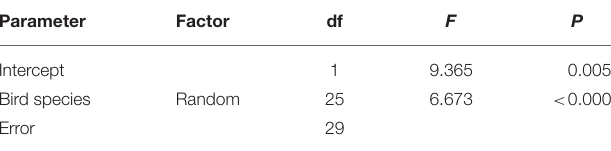
Bird species Random Error 29 Fixed factors not included in the best model were the functional group and five size and shape morphological traits (body mass, beak length:wing chord ratio, beak width:wing chord ratio, beak length:beak height ratio, Kipp’s